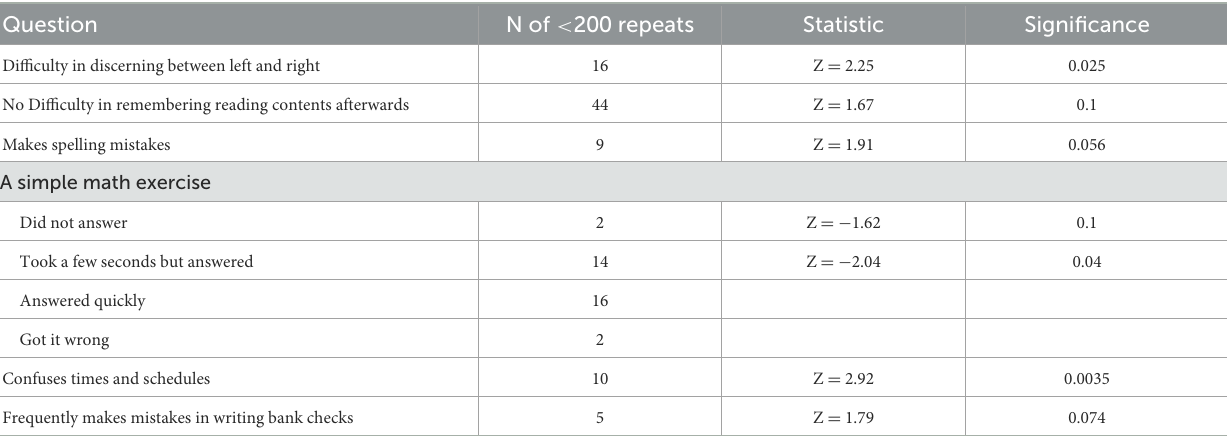
TABLE 2 Comparisons within the < 200